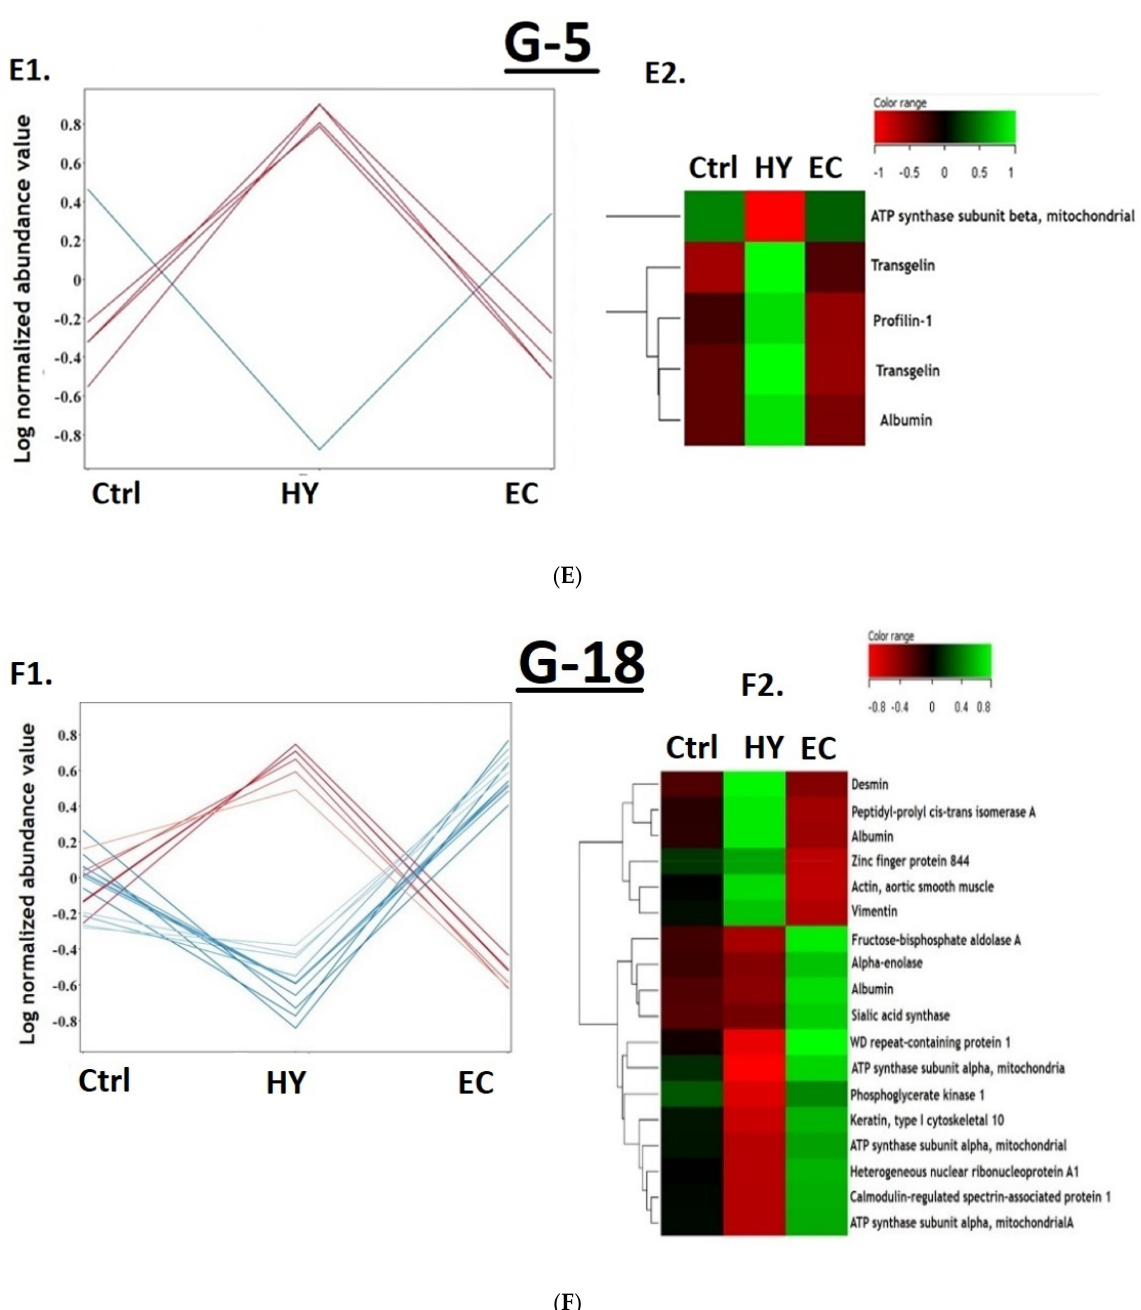
Figure 4. ( A ) Expression profile ( A1 ) and heatmap of identified features in subgroup G34 ( A2 ). ( B ) Expression profile ( B1 ) and heat map of identified features in subgroup G10 ( B2 ). ( C ) Expression profile ( C1 ) and heatmap of identified features in subgroup G9 ( C2 ). ( D ) Expression profile ( D1 ) and heat map of identified features in subgroup G11 ( D2 ). ( E ) Expression profile ( E1 ) and heat map of identified features in subgroup G5 ( E2 ). ( F ) Expression profile ( F1 ) and heat map of identified features in subgroup G18 ( F2 ).